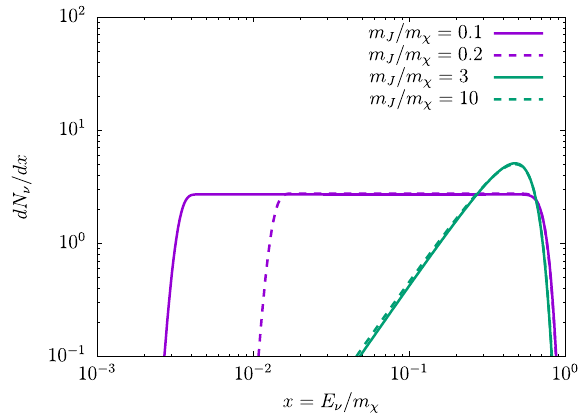
Figure 3 . Energy spectra of the neutrino ν produced by the semi-annihilation processes where the energy resolution of σ/x = 10% is taken into account. The purple lines represent the spectra for the on-shell Majoron J ( m J (cid:28) m χ ), whereas the green lines represent the spectra for the off-shell Majoron J ( m χ < m J ). See section 3.6 for the off-shell